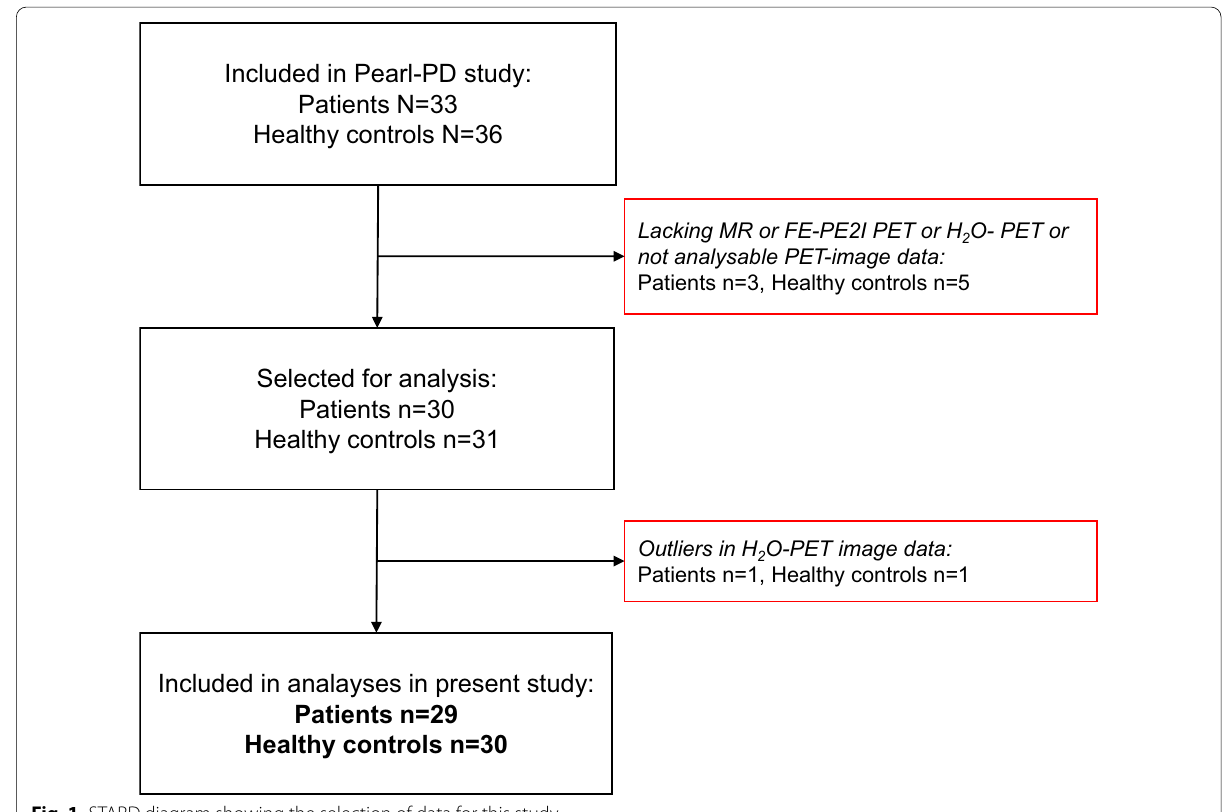
Fig. 1 STARD diagram showing the selection of data for this